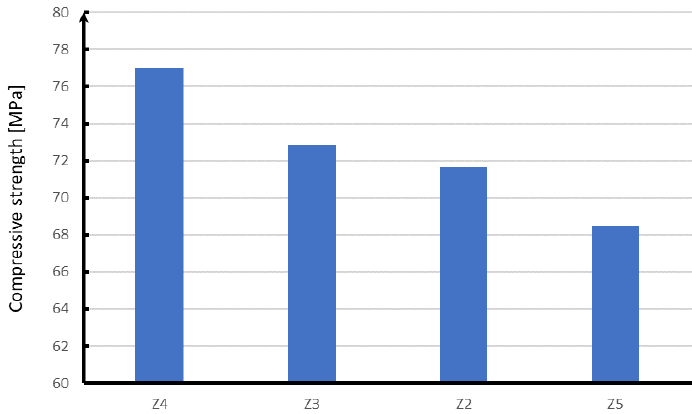
Figure 16. Results of the compressive strength Figure 16 . Results of the compressive strength test.